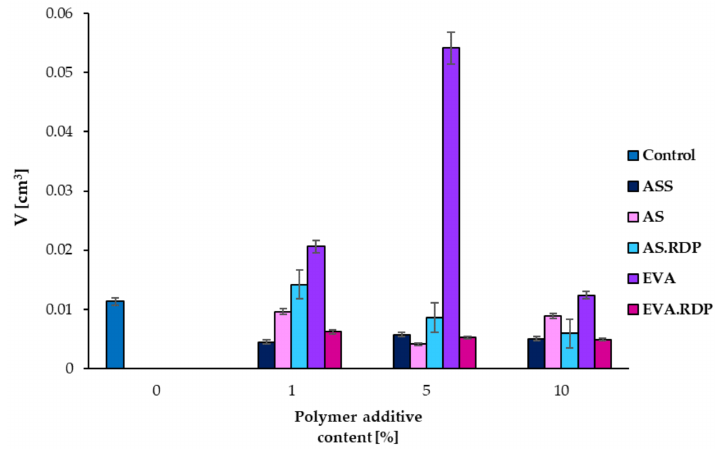
Figure 12. Changes in open pores volume of the studied concrete-based